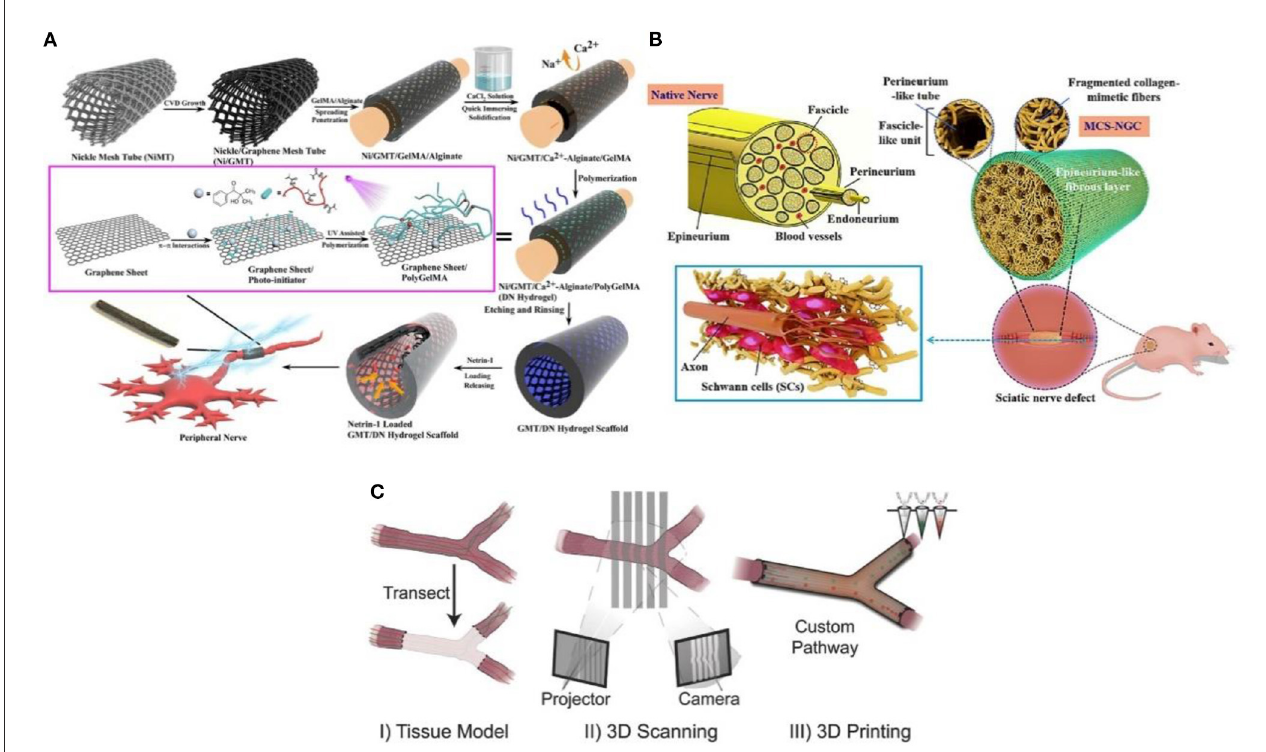
FIGURE4 (A) The graphene mesh supported double network (DN) hydrogel scaffold is loaded with netrin-1 to form a neural sleeve reprinted (adapted) with permission from (35), Copyright (2021) American Chemical Society. (B) Multichannel nerve cannula reprinted (adapted) with permission from (37), Copyright (2020) Elsevier. (C) The 3D printing realizes personalized neural channel reprinted (adapted) with permission from (38), Copyright (2015) John Wiley and